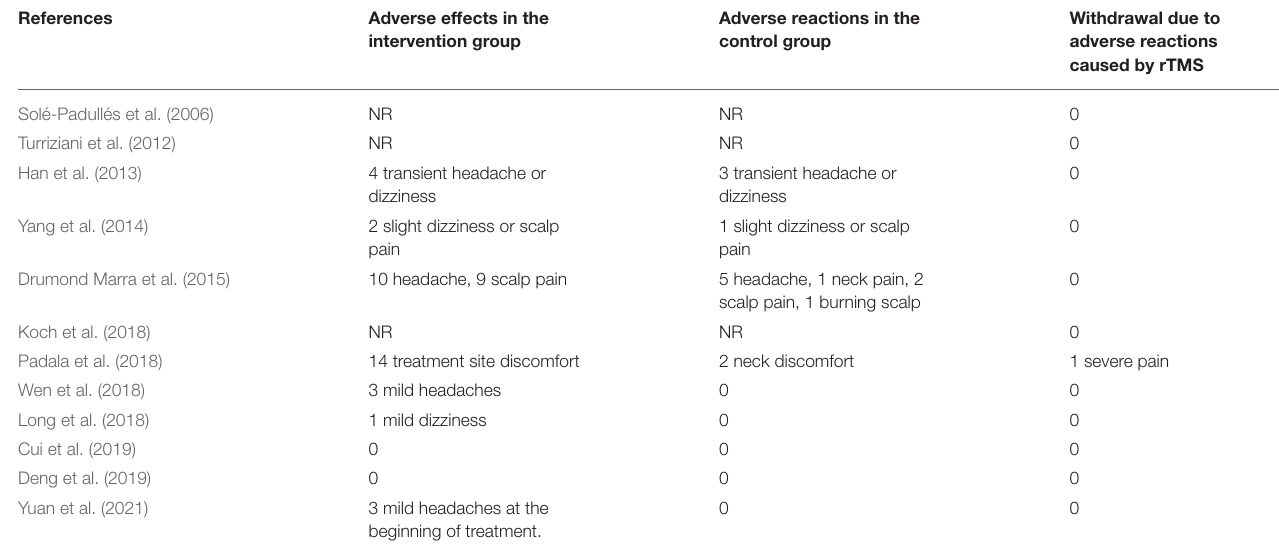
TABLE 2 | Adverse events reported in studies included in the meta-analysis.